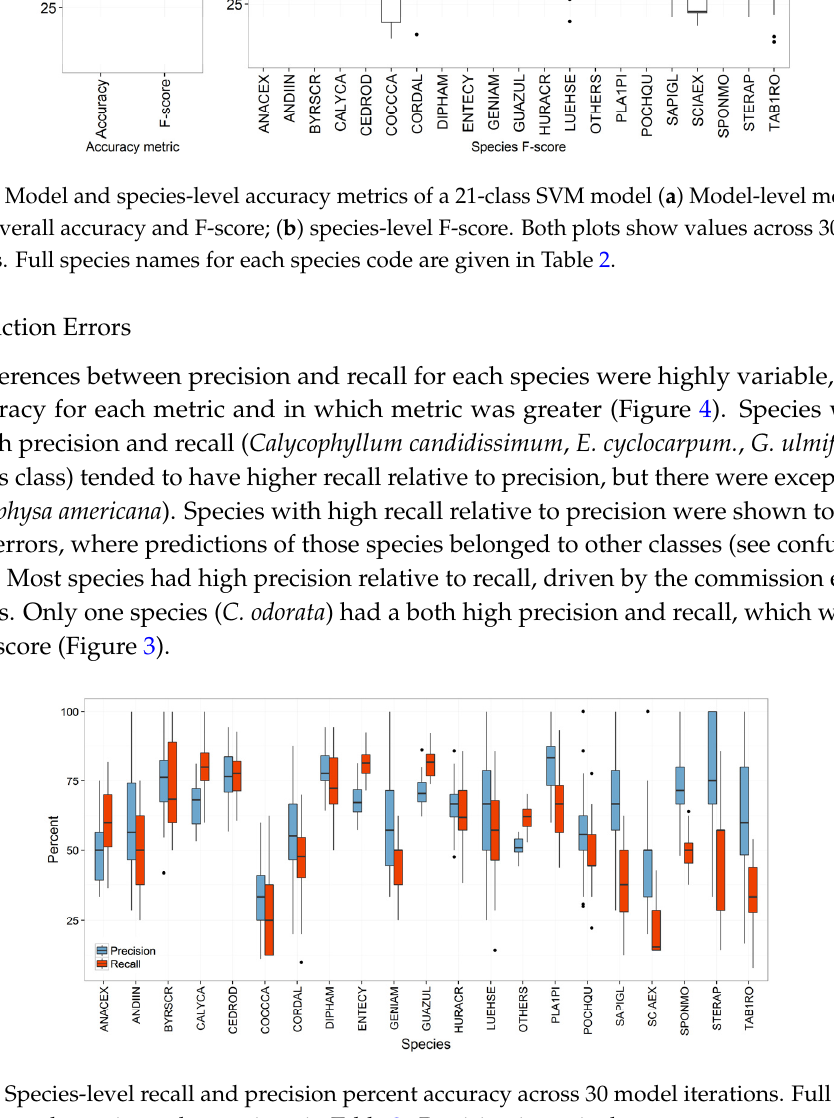
Figure 3. Model and species-level accuracy metrics of a 21-class SVM model ( a ) Model-level metrics of percent overall accuracy and F-score; ( b ) species-level F-score. Both plots show values across 30 model iterations. Full species names for each species code are given in Table 2.